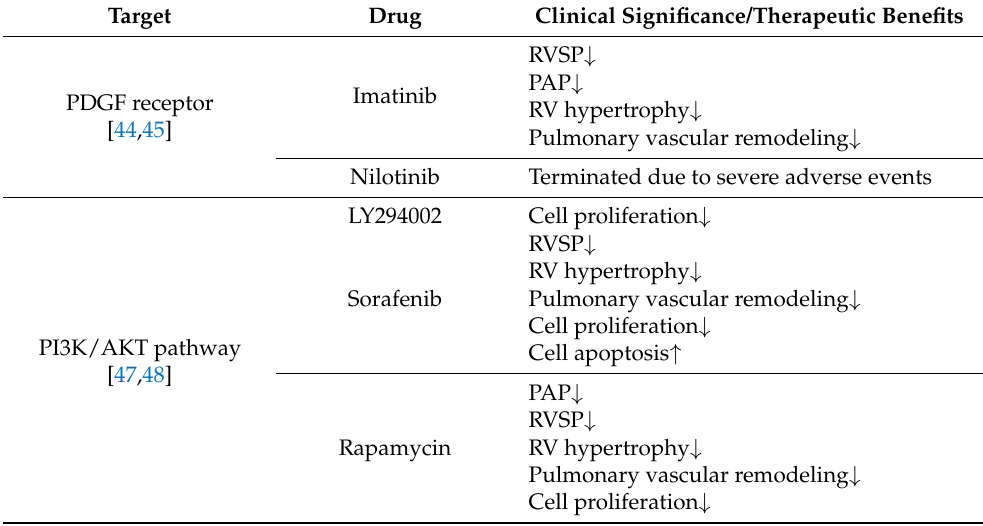
Table 2. The potential targets in PAH-targeted therapy and their clinical significances. (Numbers in parentheses denote the reference